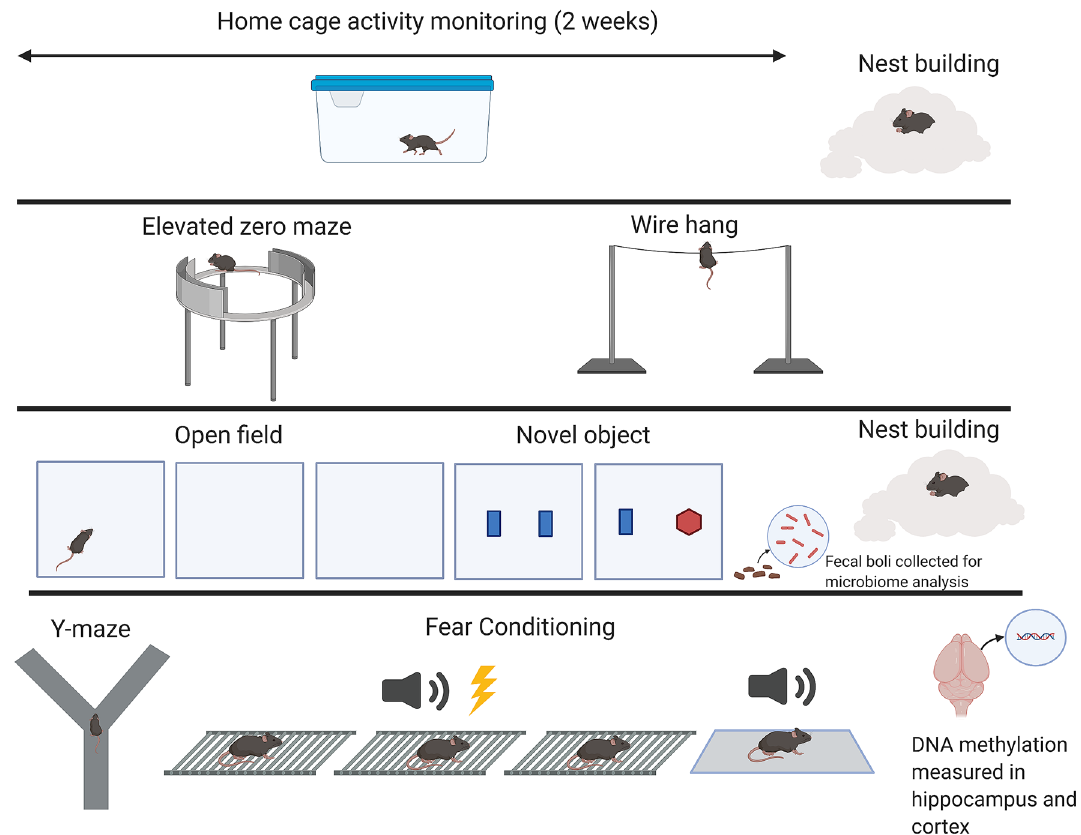
Figure 8. Schematic illustration of the experimental design. Made with